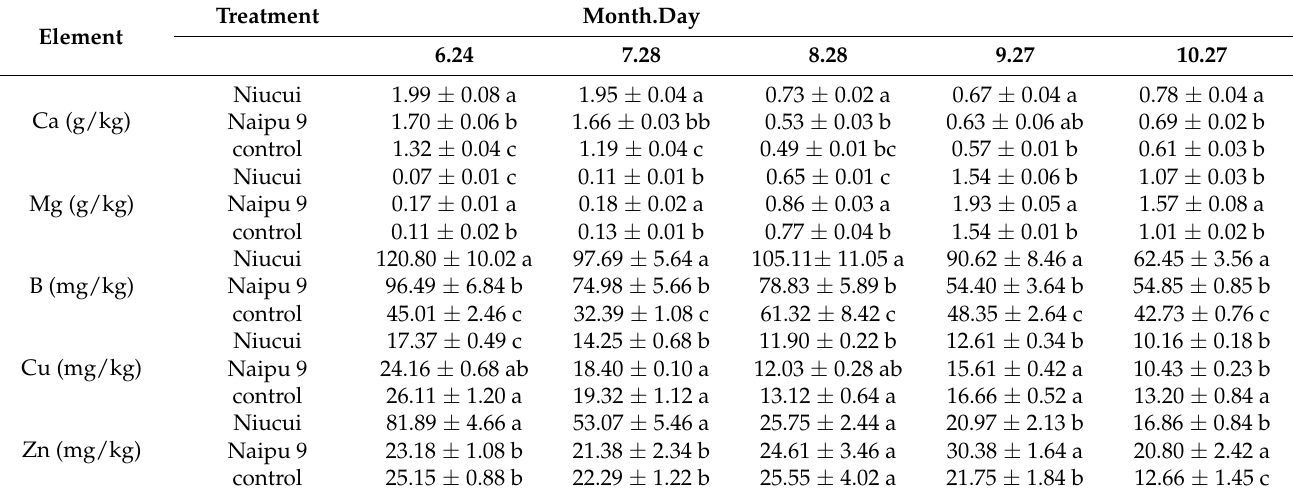
Table 4. Effect of spraying calcium fertilizer on mineral element content of apple